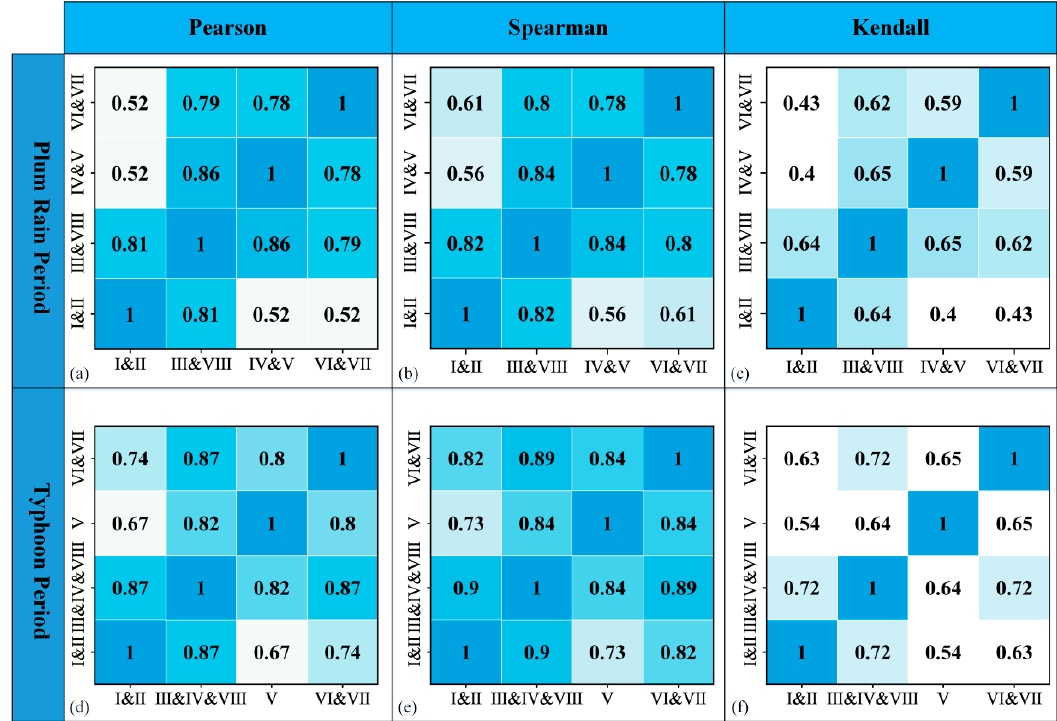
Figure 5. Correlation results of precipitation between four precipitation sub-regions. ( a – c ) are the results for the plum rain period; ( d – f ) are the results for the typhoon period; ( a , d ) are Pearson correlation results; ( b , e ) are Spearman correlation results; ( c , f ) are Kendall correlation results.